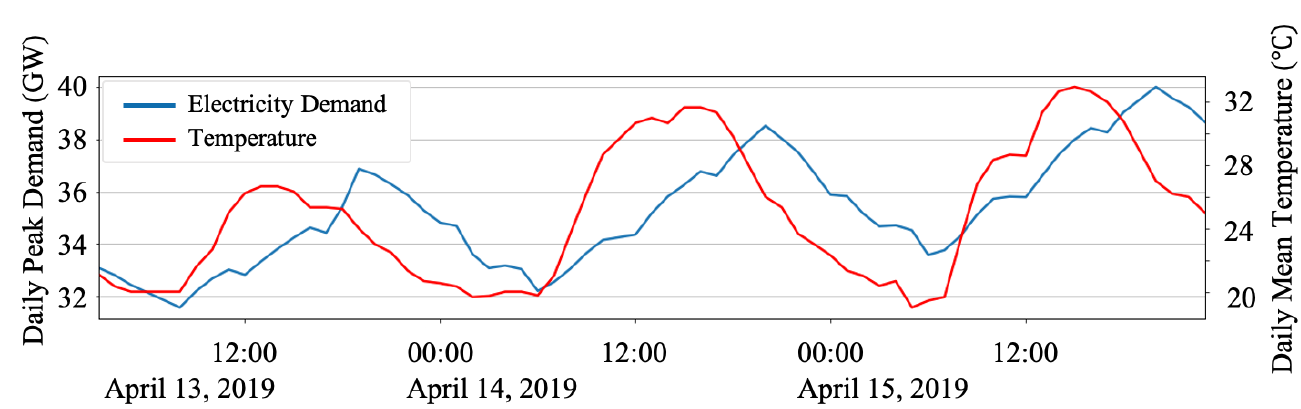
Figure 5. Electricity demands and temperatures from 13–15 April